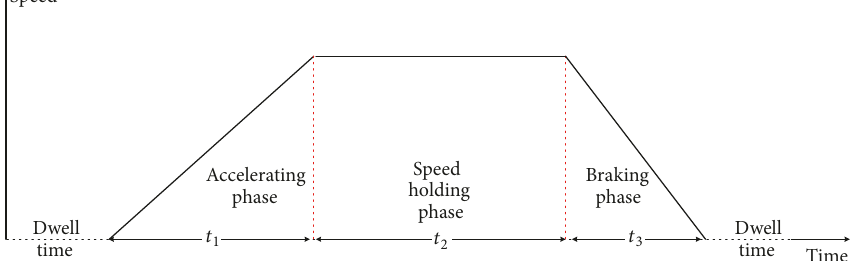
Figure 1: Three working phases (accelerating-cruising-braking) of speed profile.